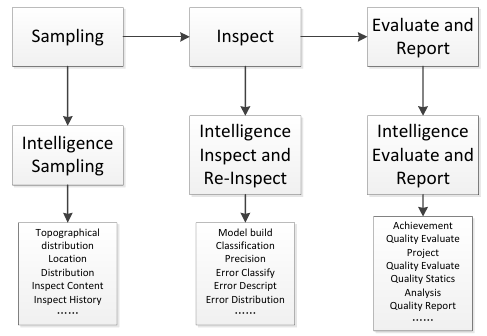
Figure 6 Intelligent In Different Inspect Step